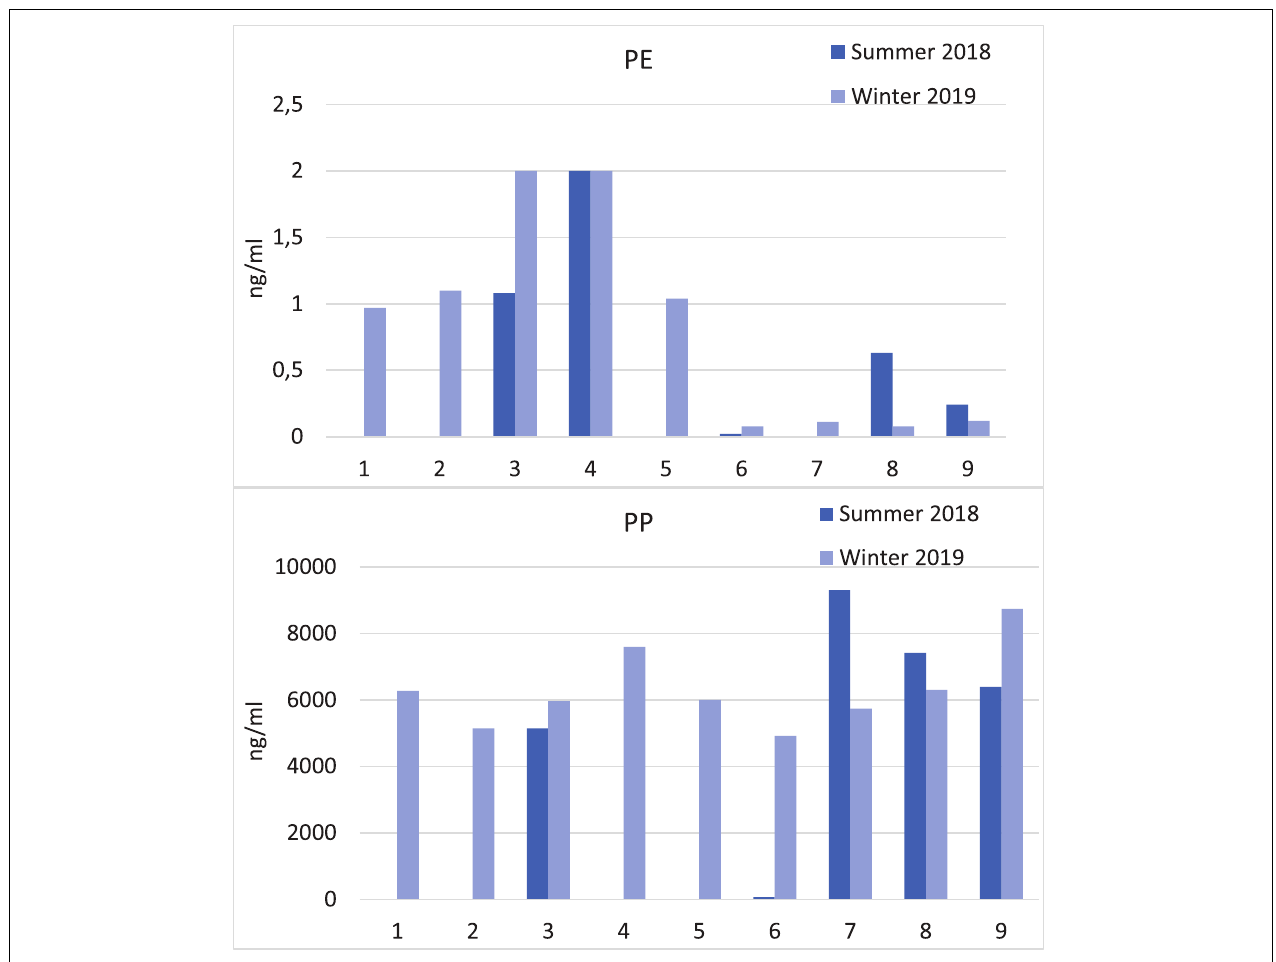
FIGURE 2 | Concentration of PE (top graph) and PP (down graph) in samples during summer period (green color) and winter period (red color) of this